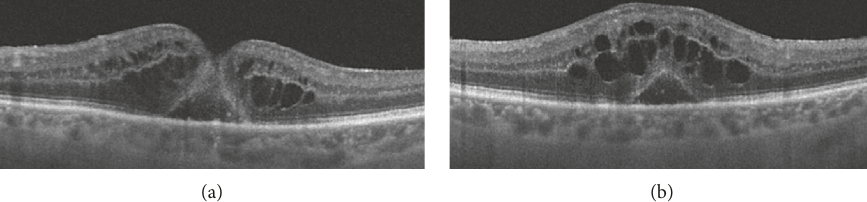
Figure 3: Optical coherence tomography (OCT) of macular edema following macular hole repair surgery. (a, b) Persistent hyporeflective intraretinal cyst after vitrectomy with internal limiting membrane peeling for